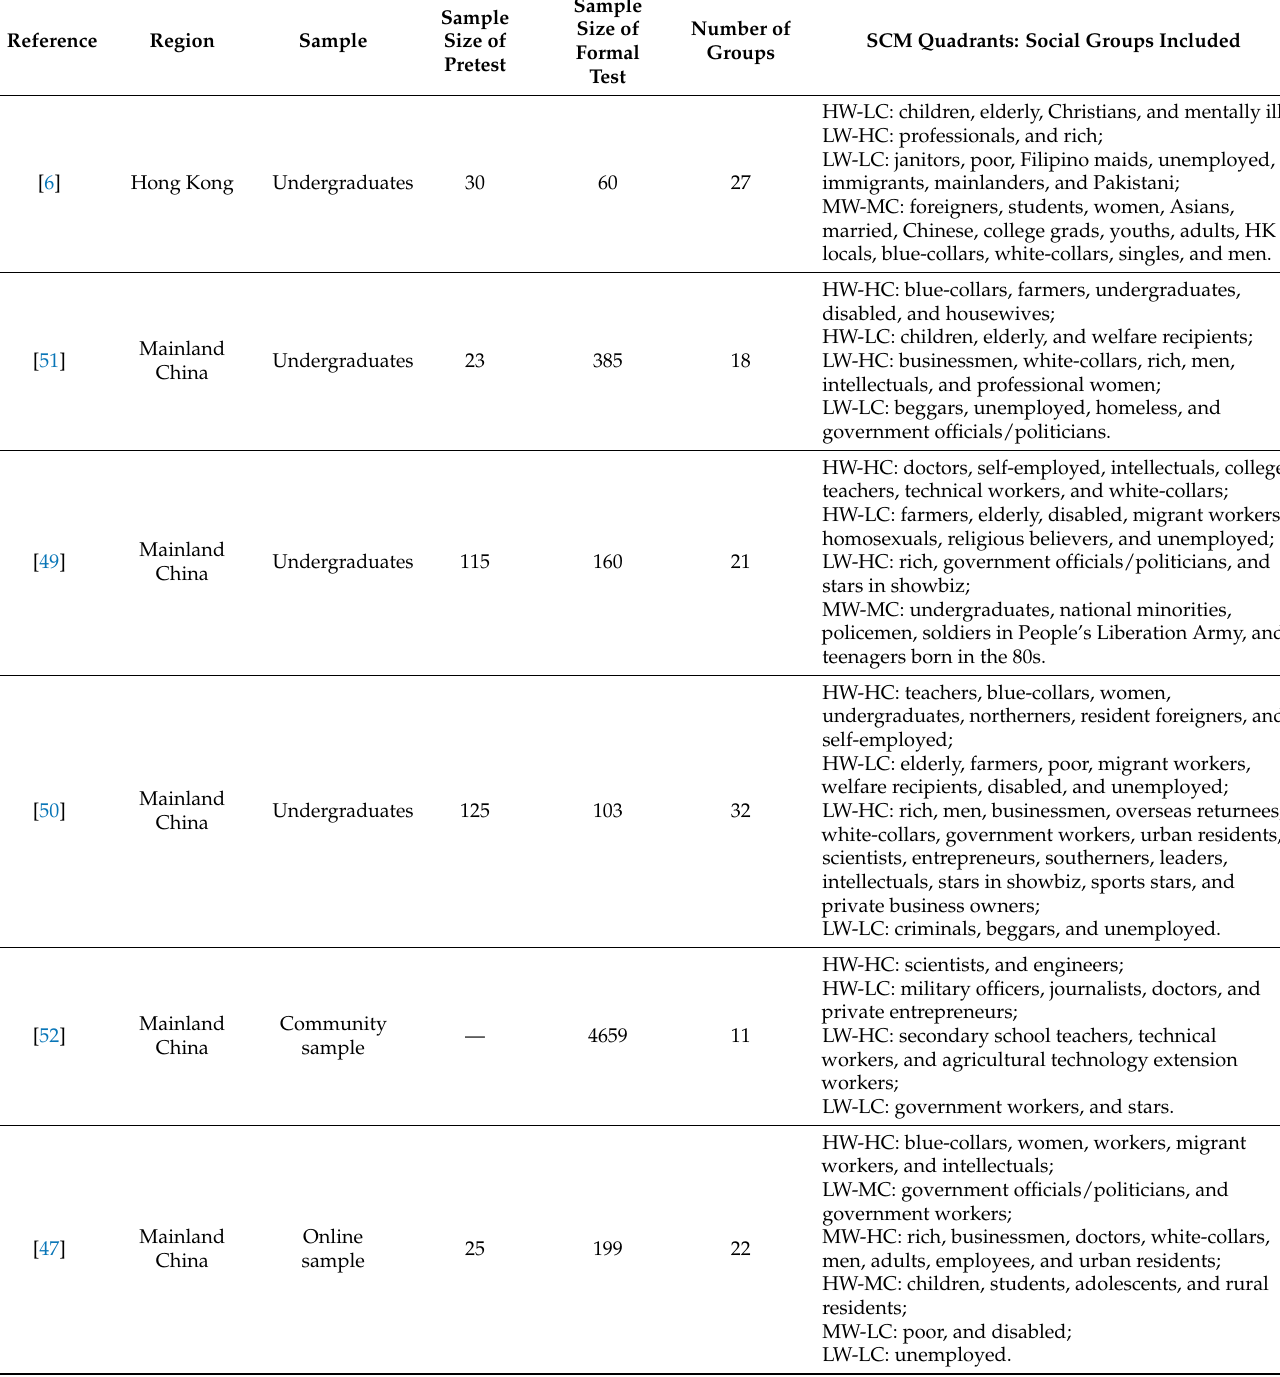
Table 1. Summary of validation studies on Stereotype Content Model in